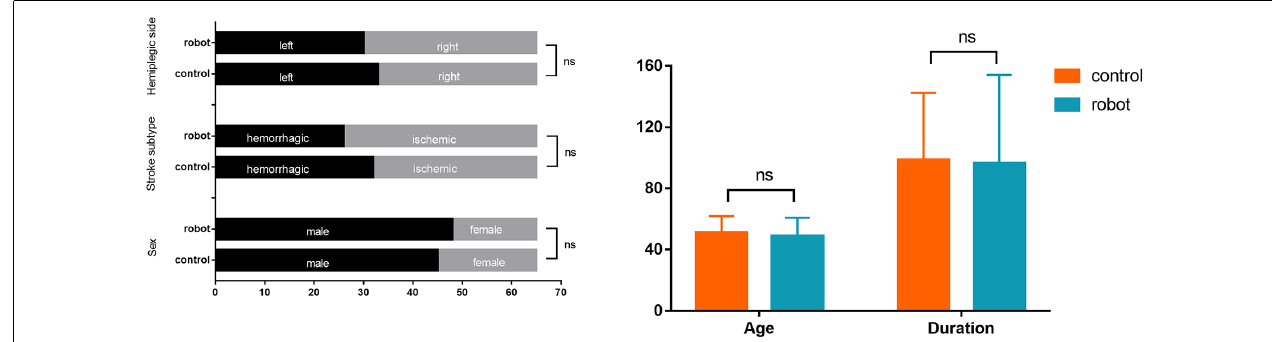
FIGURE 3 | Baseline characteristics of the enrolled subjects. Left panel: categorical data; Right panel: continuous data. Error bars indicate the standard deviation. ns: not significant.